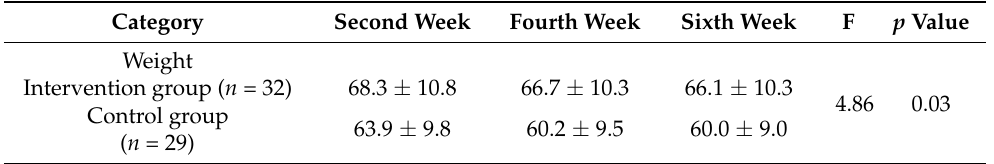
Table 3. Comparison of weight between the two groups (Mean ± SD).